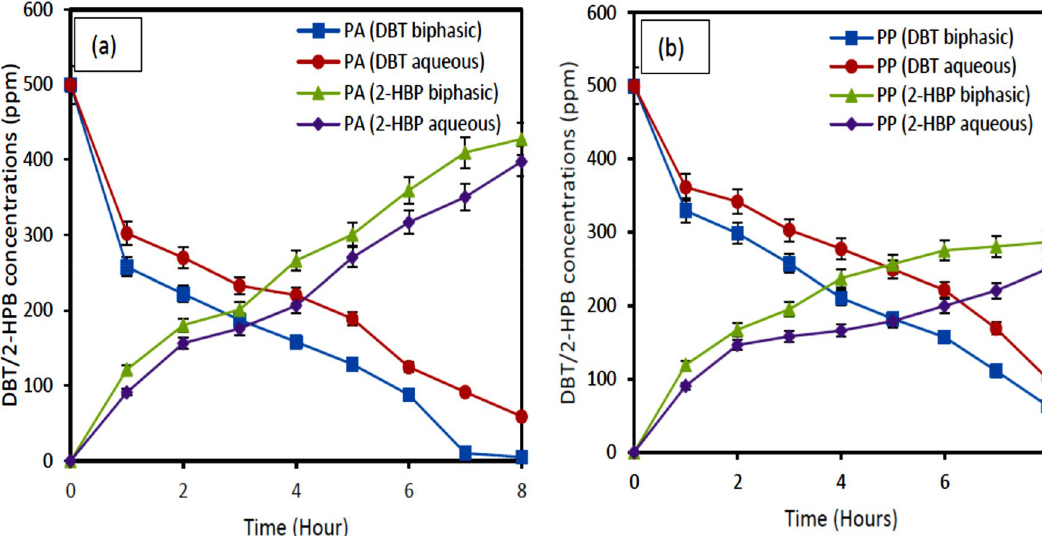
Figure 8. Effect of biphasic media on biodesulfurization of DBT and formation of 2-HBP by ( a ) Pseudomonas aeruginosa ( b ) Pseudomonas putida. Experimental conditions : Oil-to-water ratio 1:4. Initial DBT concentration 500 ppm, Temperature 37 °C (Pseudomonas aeruginosa) 30 °C (Pseudomonas putida); shaking speed 130